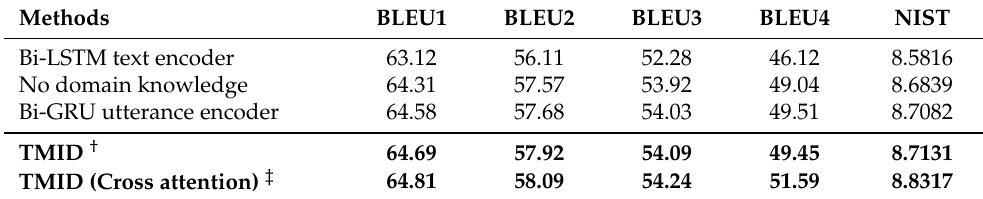
Table 3. Ablation study of TMID.